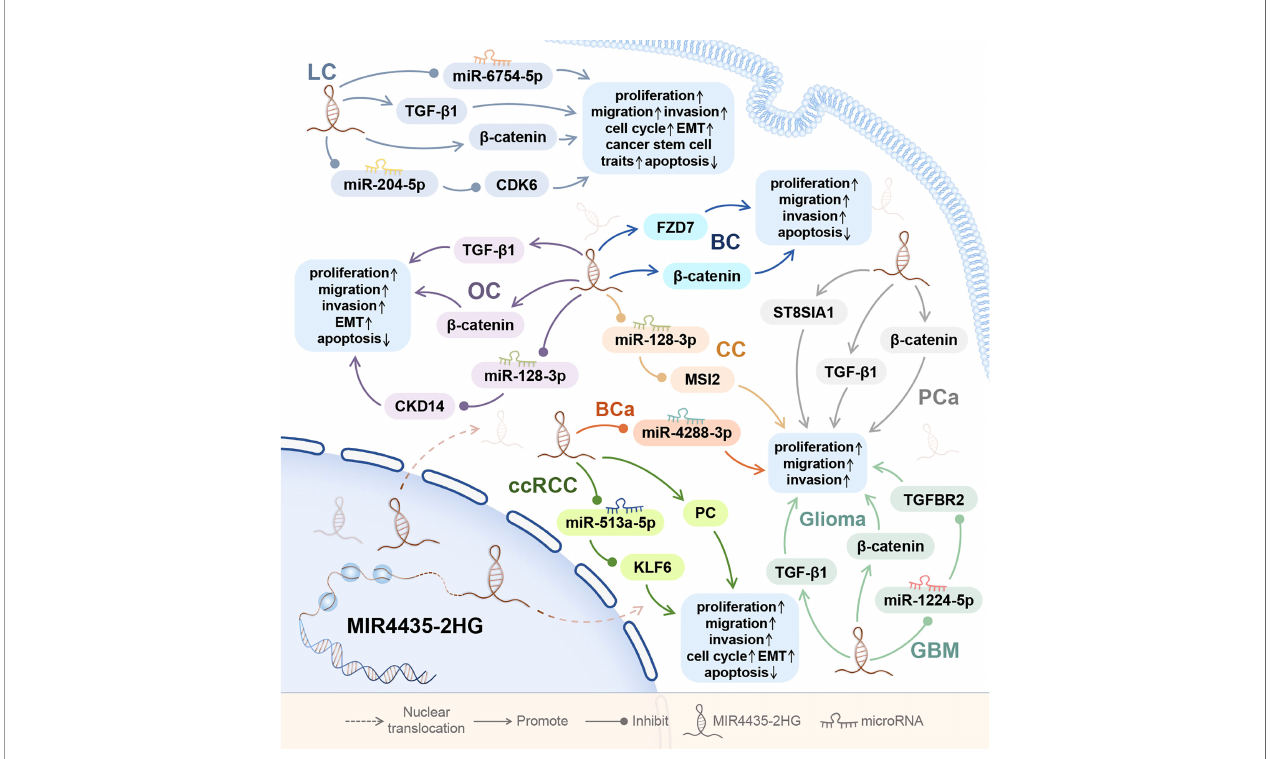
FIGURE 3 | The role of MIR4435-2HG in tumors of the respiratory system, reproductive system, urinary system, and nervous system. MIR4435-2HG can also affect the proliferation, migration, invasion, apoptosis, EMT, and cell cycle of tumor cells by regulating downstream genes. Tumor of the respiratory system consists of lung cancer (LC); Tumors of the reproductive system consist of ovarian cancer (OC), cervical cancer (CC), breast (BC), and prostate cancer (PCa); Tumors of the urinary system include clear cell renal cell carcinoma (ccRCC) and bladder cancer (BCa); and tumor of the nervous system includes